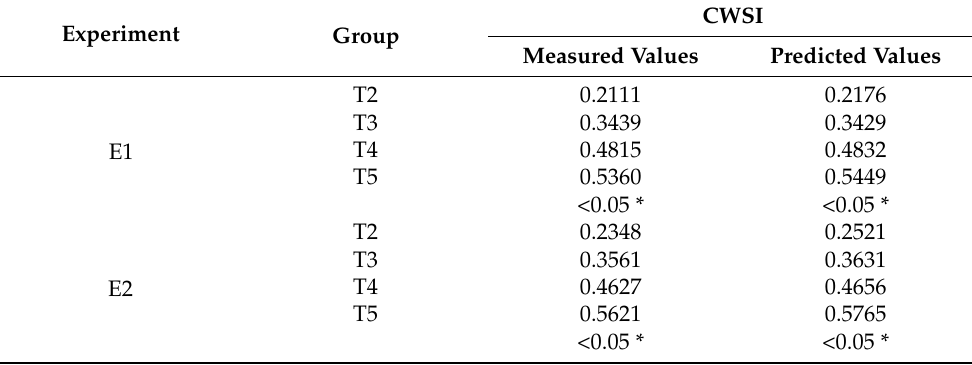
Figure 12. Comparison of CWSI values based on measured and predicted T wet and T dry for E1 ( a ) and E2 ( b ). The black, red, blue, and green colors represent Groups T2, T3, T4, and T5, respectively. M and P denote measurement and prediction, respectively. Table 7. The mean CWSI for different groups in two experiments.